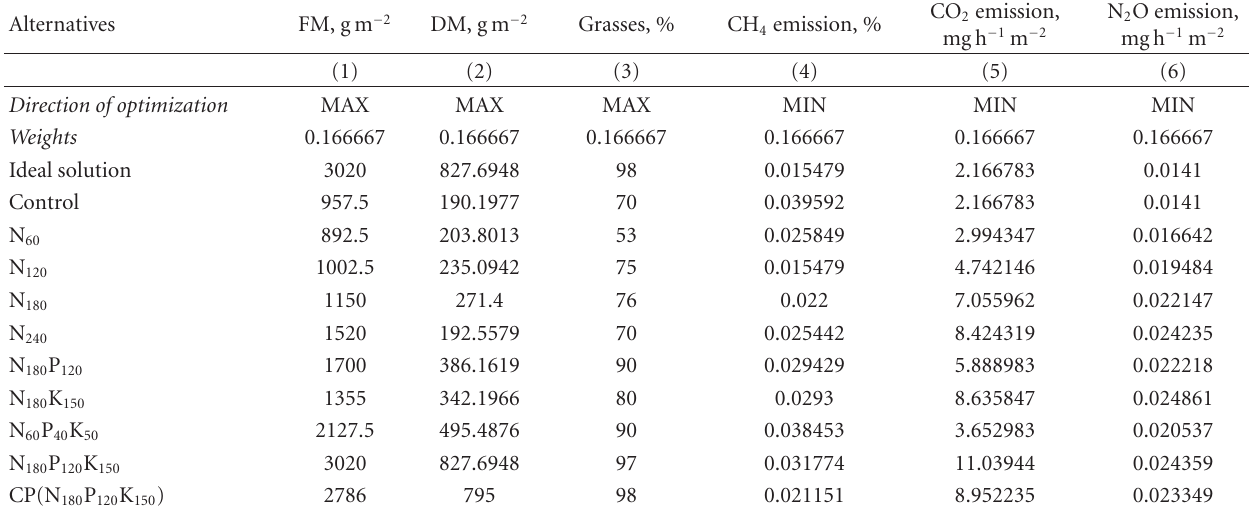
Table 4: Measurement results in grasslands (initial decision-making matrix X ). FM-fresh mass; DM-dry materials. Alternatives